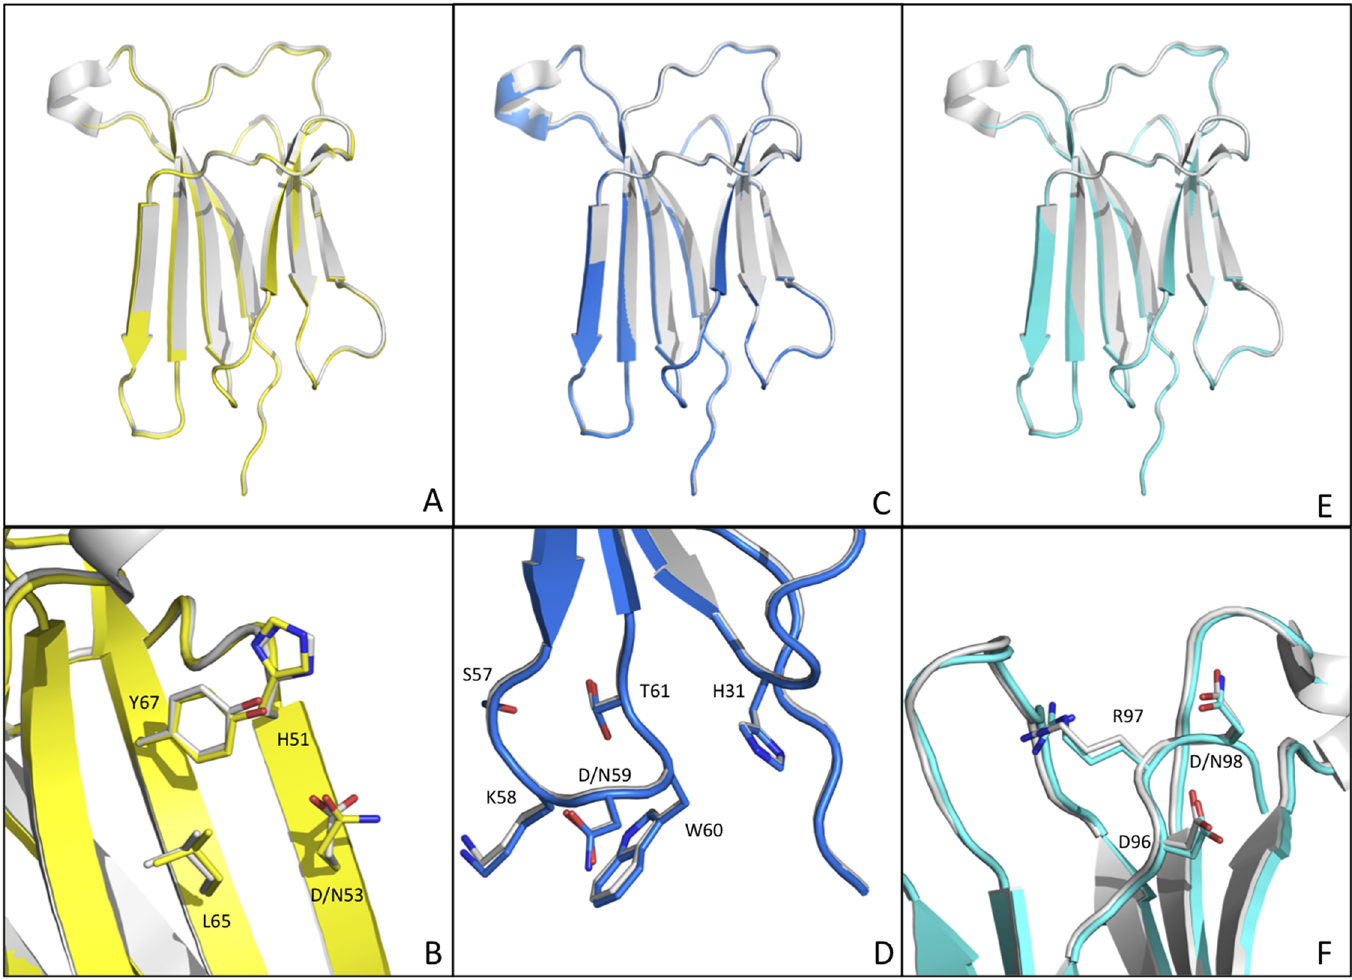
Fig 4. Comparison of the crystal structures of D-to-N β 2m variants. (A), (C) and (E) Cartoon representation of the β 2m variants D53N (yellow), D59N (blue) and D98N (cyan) individually overlaid onto the structure of wt β 2m (light grey, PDB ID 2YXF). (B), (D) and (F) Close up views of the mutation sites in D53N, D59N and D98N, color coded as in A C and E panels; side chains of the mutated and neighboring residues are shown as sticks and